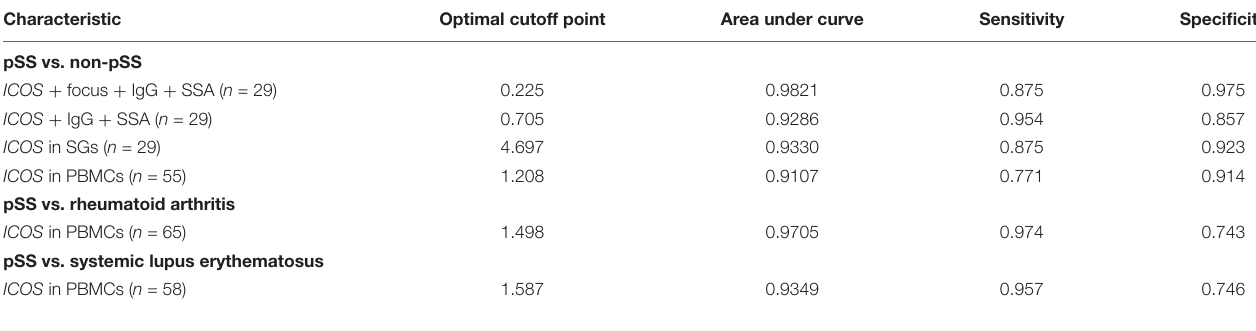
TABLE 3 | Diagnostic value of ICOS in salivary glands (SGs) and peripheral blood mononuclear cells (PBMCs) for primary Sjögren’s syndrome (pSS).